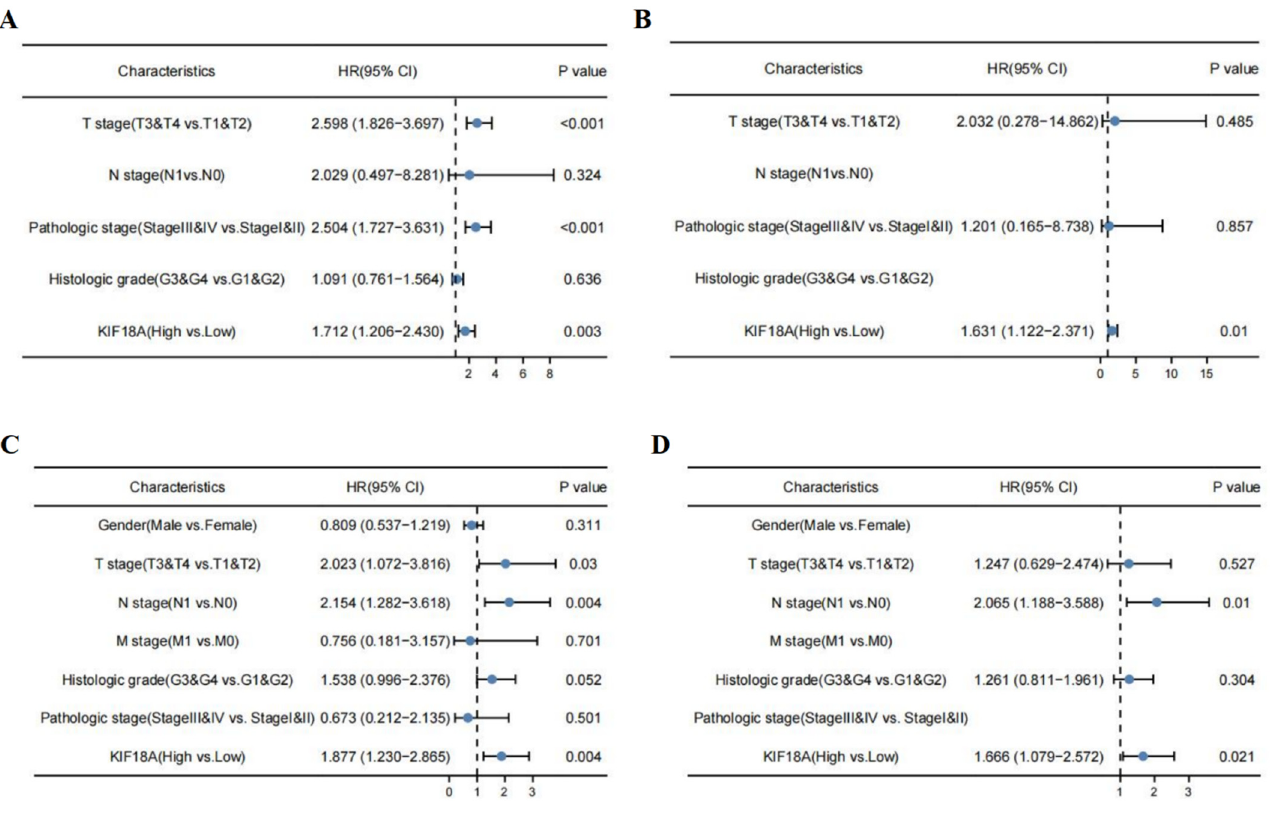
Figure 13. Univariate and multivariate analyses for OS in LIHC ( A , B ) and PAAD ( C , D ).